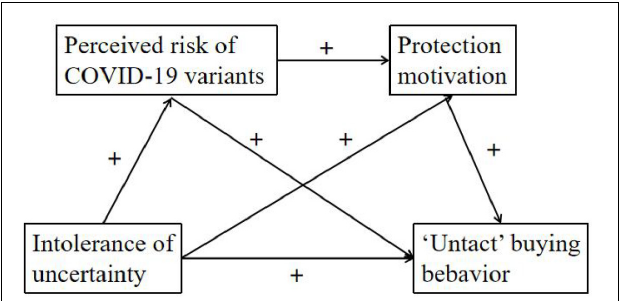
FIGURE 1 | The conceptual model. + means positive relationship.